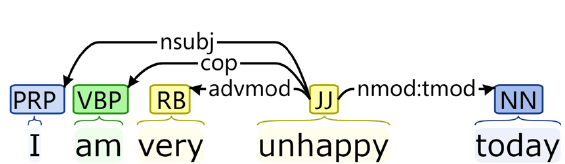
Figure 4. An example of syntactic dependency tree of a given sentence. PRP: pronoun,